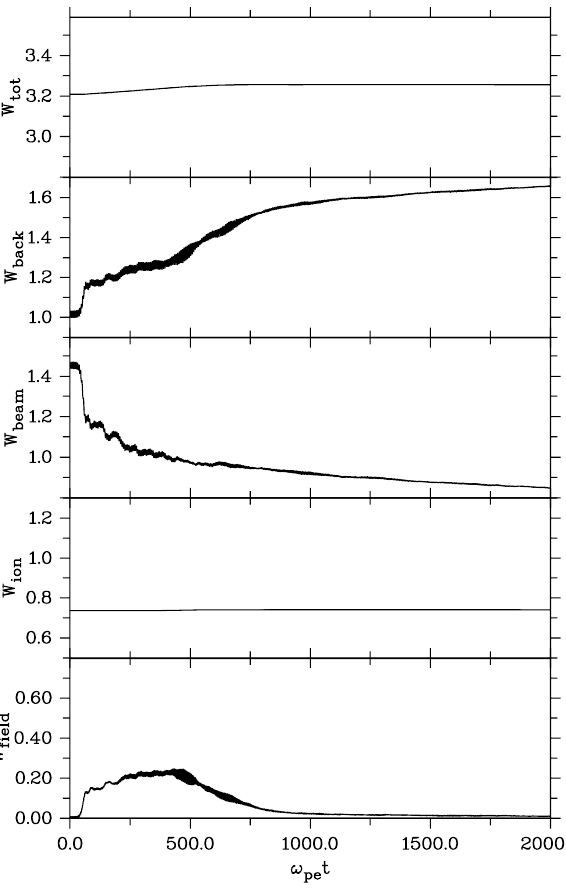
Figure 7. Distribution of the energy content W tot of the simulation box over background electrons ( W back ), beam electrons ( W beam ), ions ( W ion ) and the electrostatic field ( W field ) as function of time. The energy is in units of the initial thermal energy of the background electrons. E tot remains constant within ∼